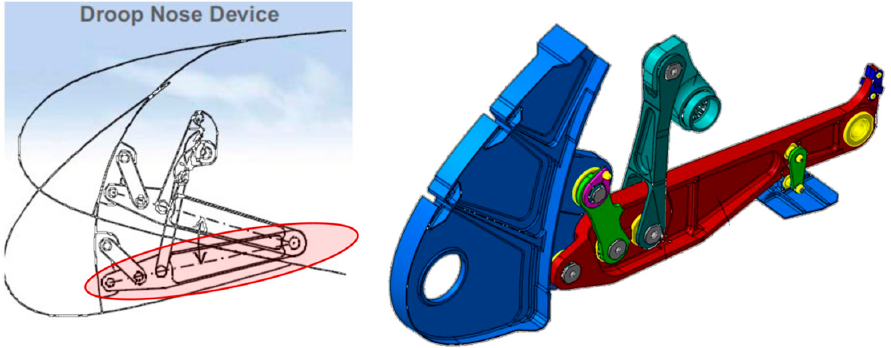
Figure 1. Schematics of the hinge arm of the droop nose mechanism on the Airbus A380 wing leading edge (side section) [17,18].